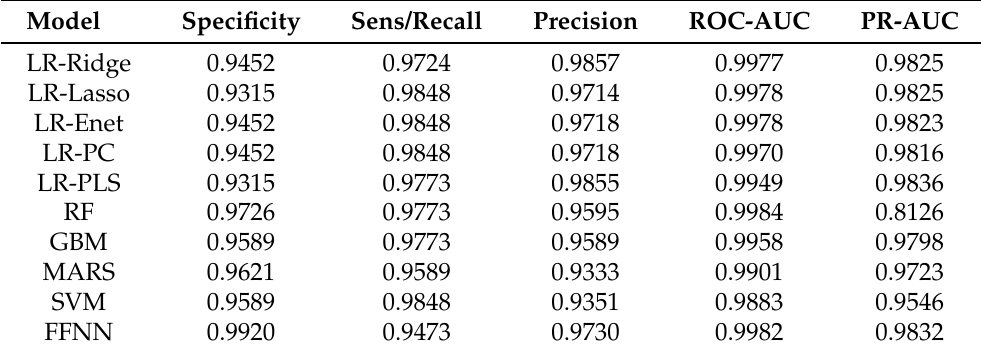
Table 11. Performance assessment of the 10 models for the breast cancer